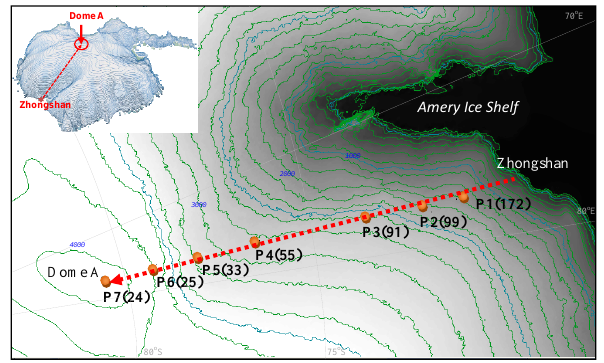
Figure 1. Snowpit locations sampled during the 2012–2013 Chi- nese National Antarctic Research Expedition (CHINARE) inland traverse. The numbers in parentheses denote the annual snow ac- cumulation rates (kgm − 2 a − 1 ) which are extended to 2013 from bamboo stick field measurements (Ding et al., 2011).